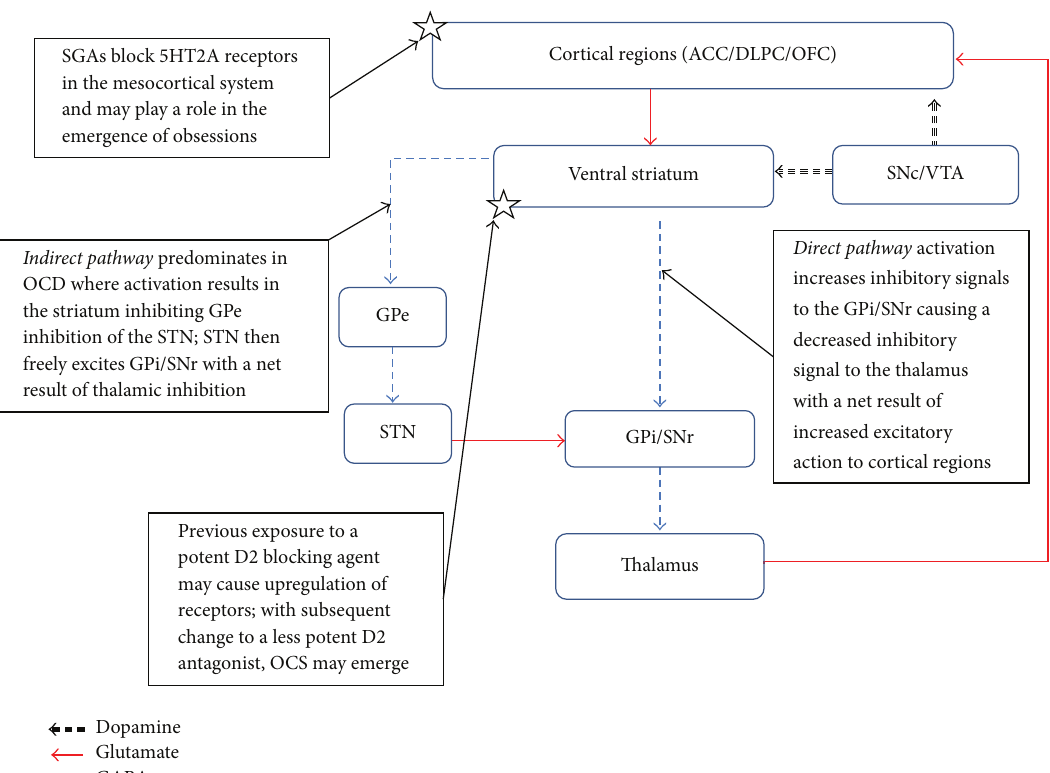
Figure1:Briefoverview ofOCDpathophysiology andsuspected targetsinvolving antipsychotic-induced OCS/OCD.ACC:anterior cingulate cortex; DLPC: dorsal lateral prefrontal cortex; GPe: globus pallidus pars externalis; GPi: globus pallidus pars internalis; OFC: orbitofrontal cortex; STN: subthalamic nucleus; SNc: substantia nigra pars compacta; SNr: substantia nigra pars reticulata; VTA: ventral tegmental